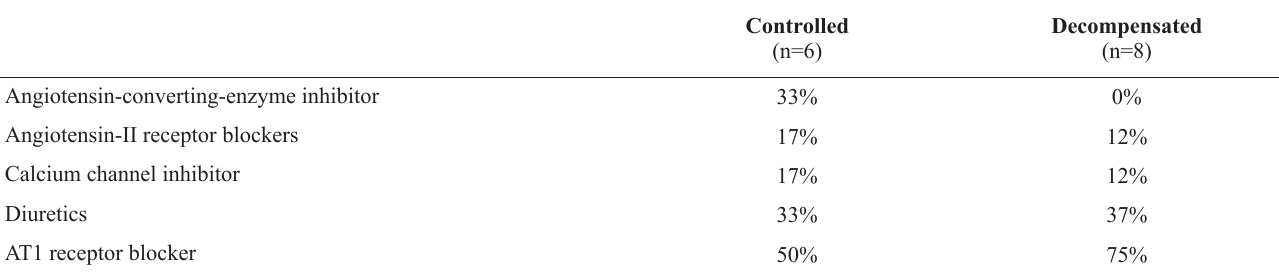
Table 1 - Antihypertensive therapy is currently used by the study participants.